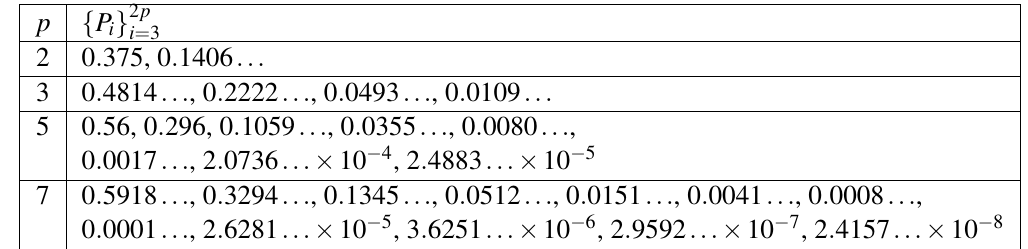
for p = 2 , 3 , 5 , i = 3